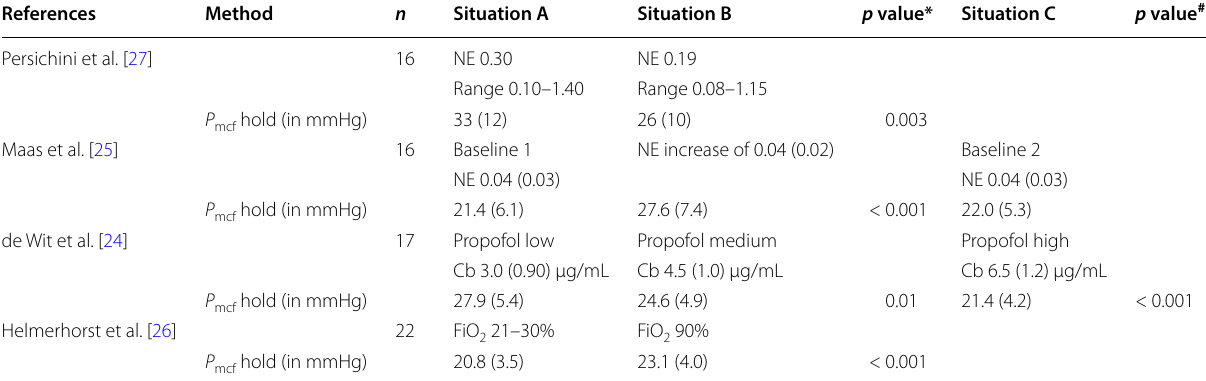
Table 3 P and pharmacodynamics mcf